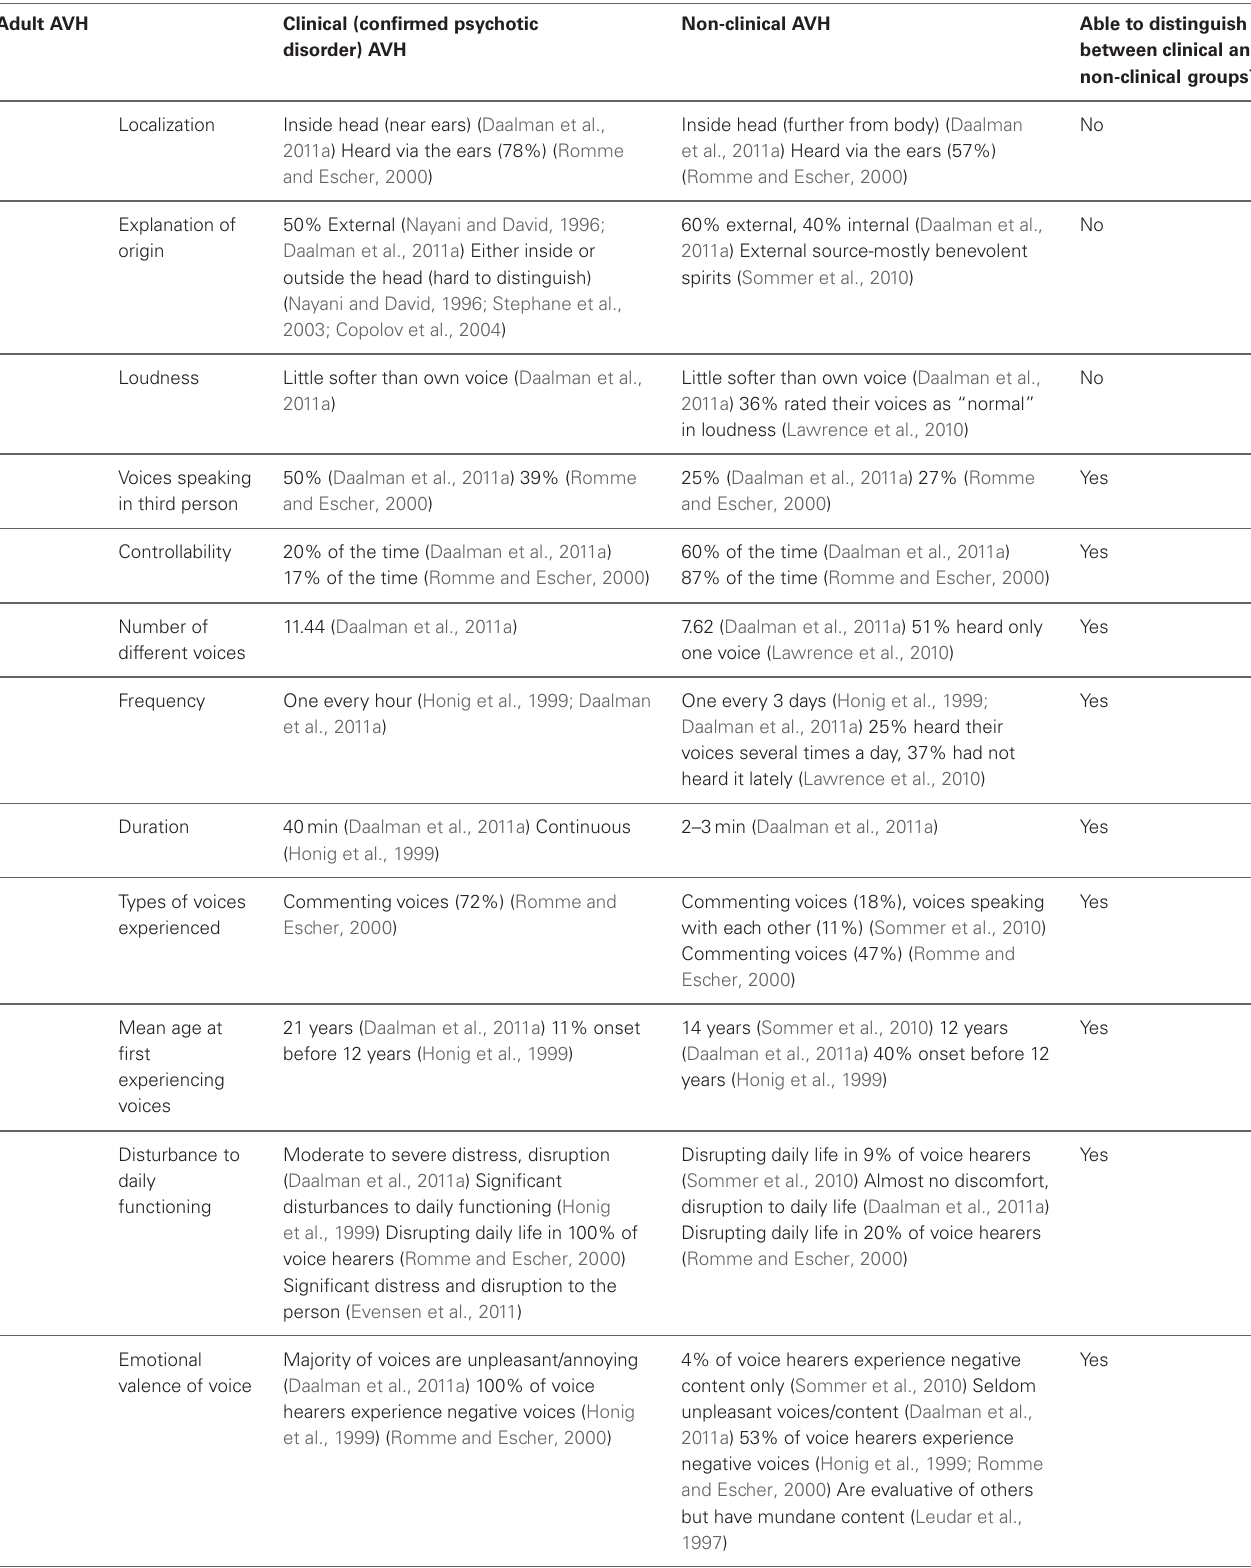
Table 1 | Phenomenological characteristics of AVH in clinical and non-clinical groups. Adult AVH Able to distinguish